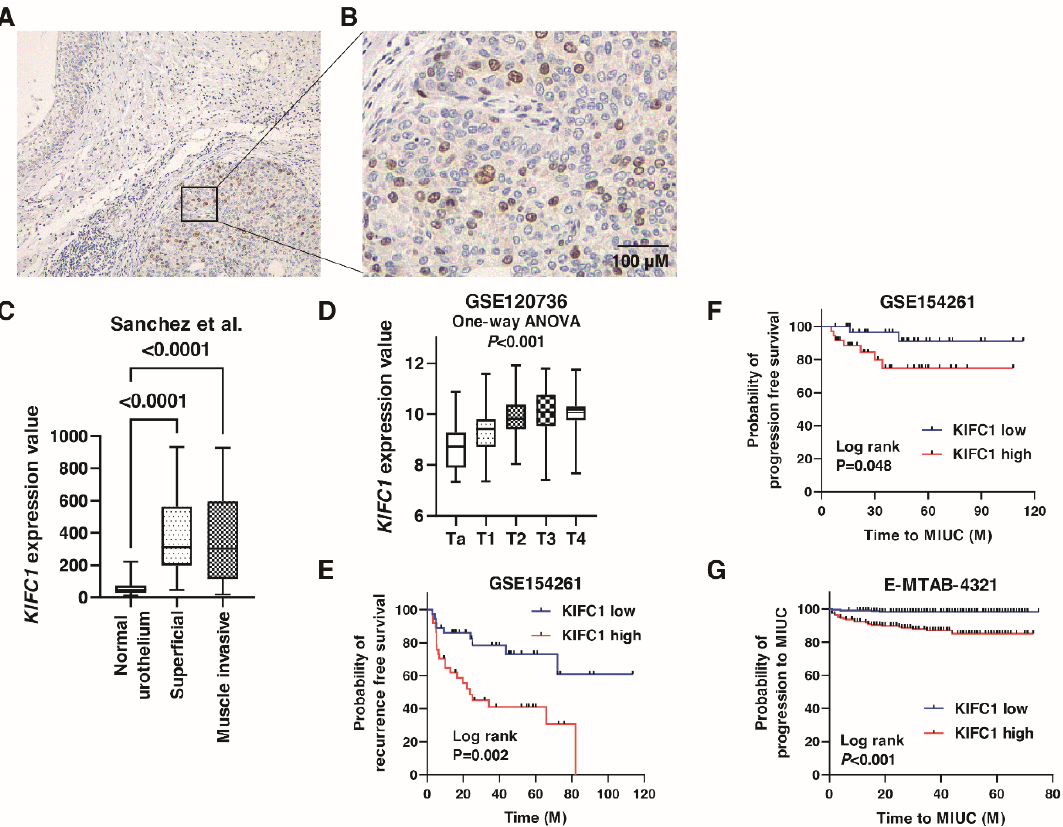
Figure 1. Expression of KIFC1 in bladder cancer (BC). ( A ) Immunohistochemical staining of KIFC1 in the non-neoplastic urothelium and BC. Original magnification: 100×. ( B ) Immunohistochemical staining of KIFC1 in BC. Original magnification: 400×. ( C ) Box plot of KIFC1 expression in normal urothelium, superficial BC, and muscle-invasive BC from the study by Sanchez et al. [21]. ( D ) Box plot of KIFC1 expression according to T stage from the study GSE120736. ( E ) Kaplan-Meier plot of recurrence-free survival of T1 BC patients according to KIFC1 expression from the study (GSE154261). ( F , G ) Kaplan-Meier plot of progression-free survival of T1 BC patients according to KIFC1 expression after prostatectomy from the studies GSE154261 and E-MTAB-4321.